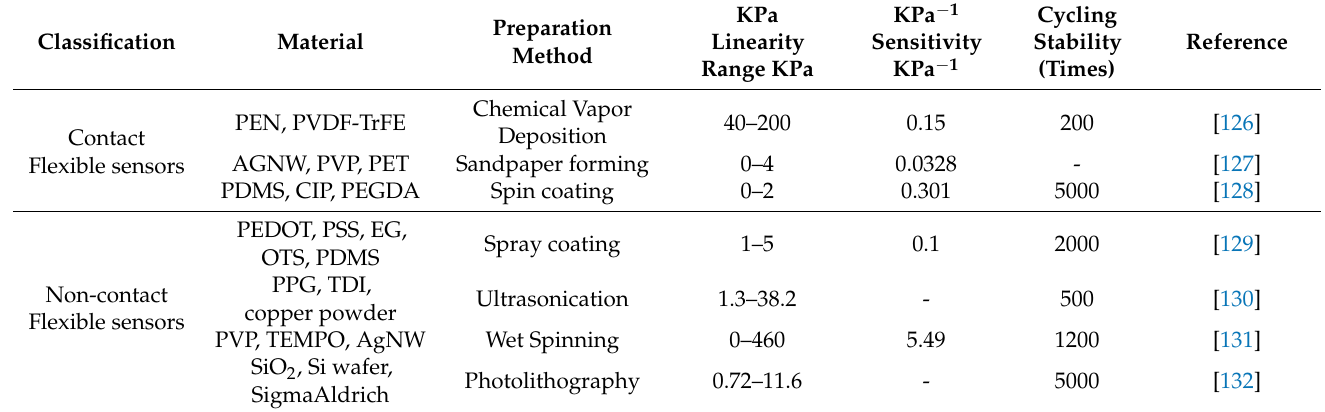
Table 3. Comparison of flexible sensors using different methods of